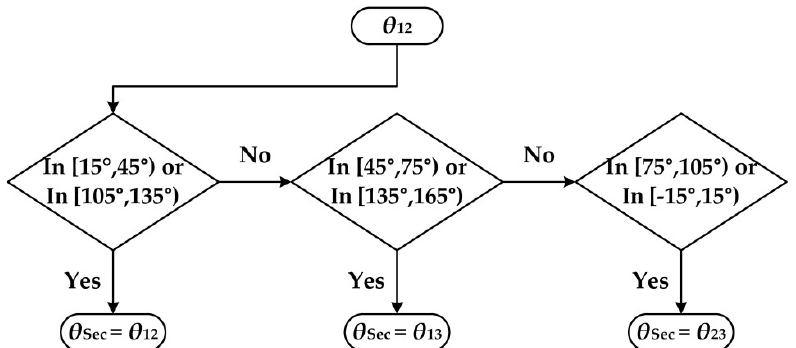
Figure 3. Functional diagram of the section algorithm.